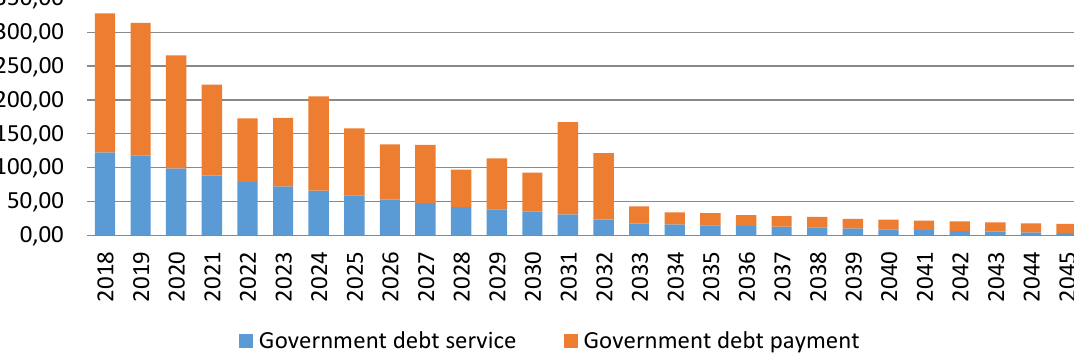
Figure 9. Government debt service and payment, Ukraine, UAH